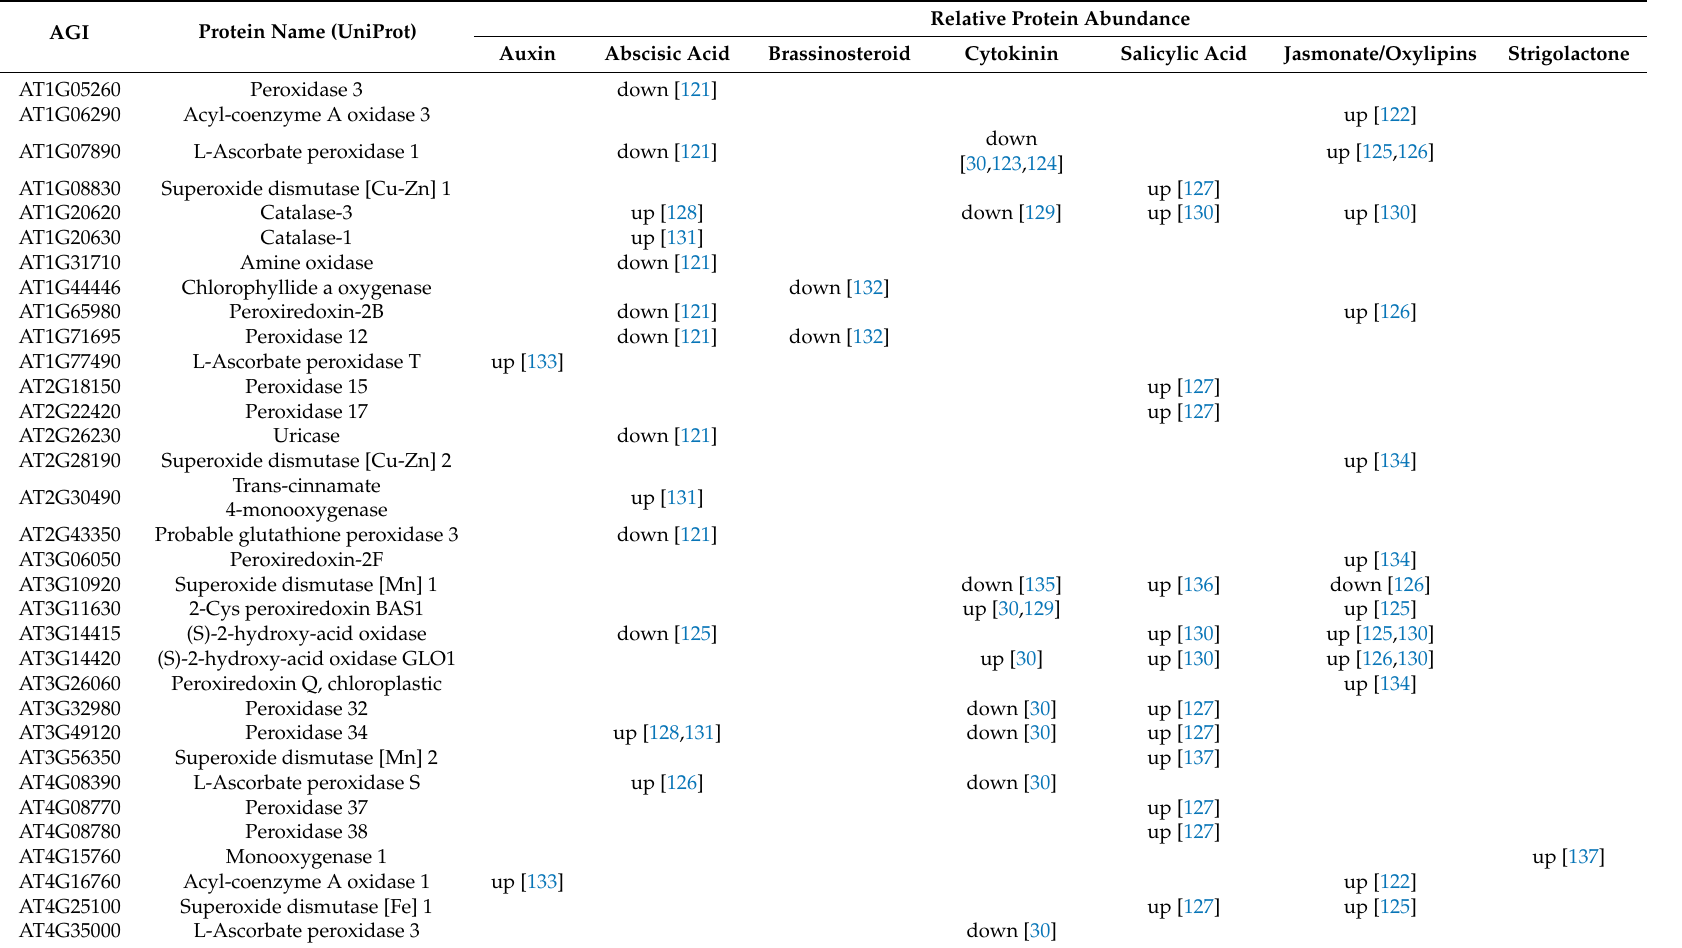
Table 1. Proteins of hydrogen peroxide metabolism in Arabidopsis identified in phytohormone-responsive proteomics analyses. Based on a previously published overview of hormone-responsive proteins